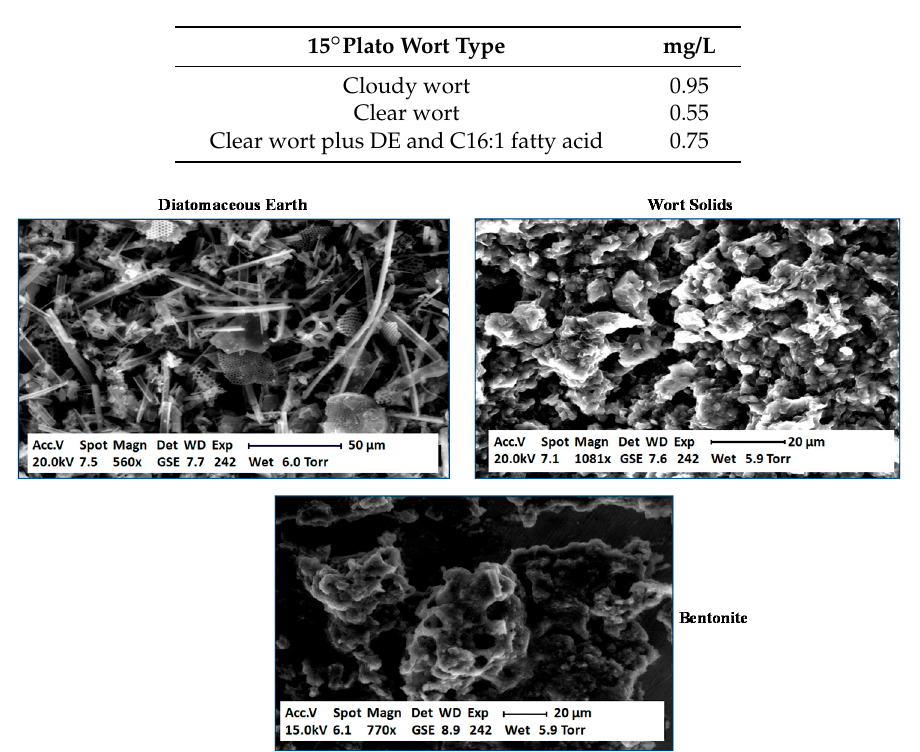
Figure 10. Environmental scanning electron microscopy (SEM) of different wort solid materials.